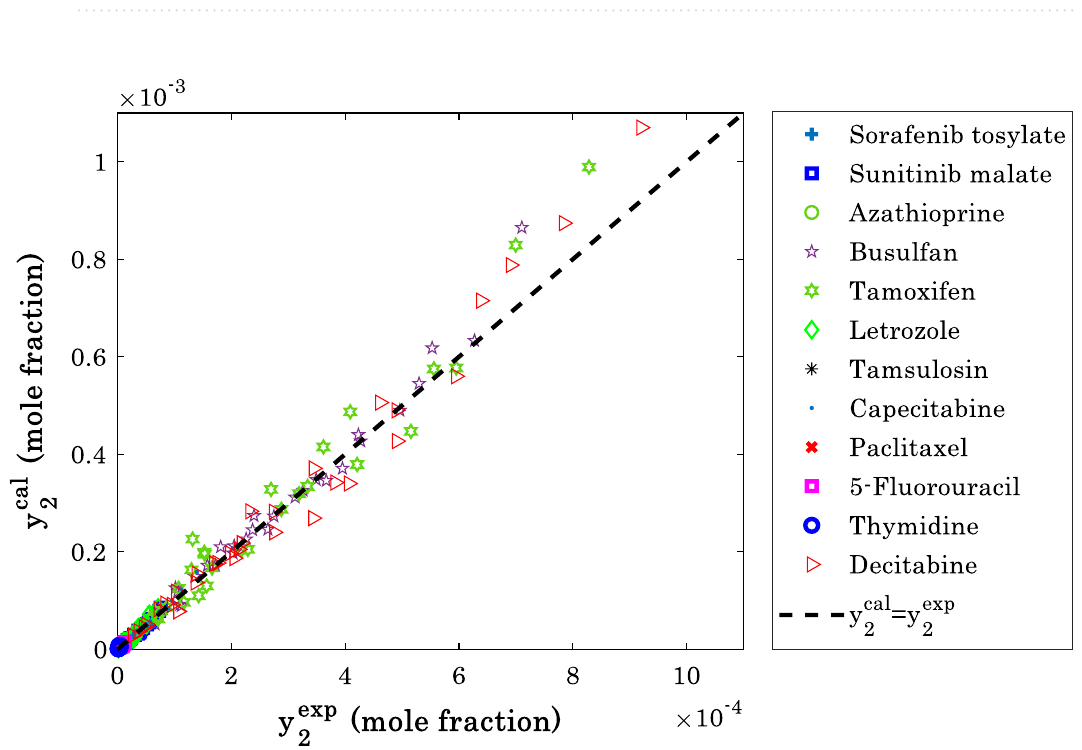
Figure 7. Cross-plot of the modified Arrhenius predictions versus experimental measurements for anti-cancer drug solubility in supercritical CO 2